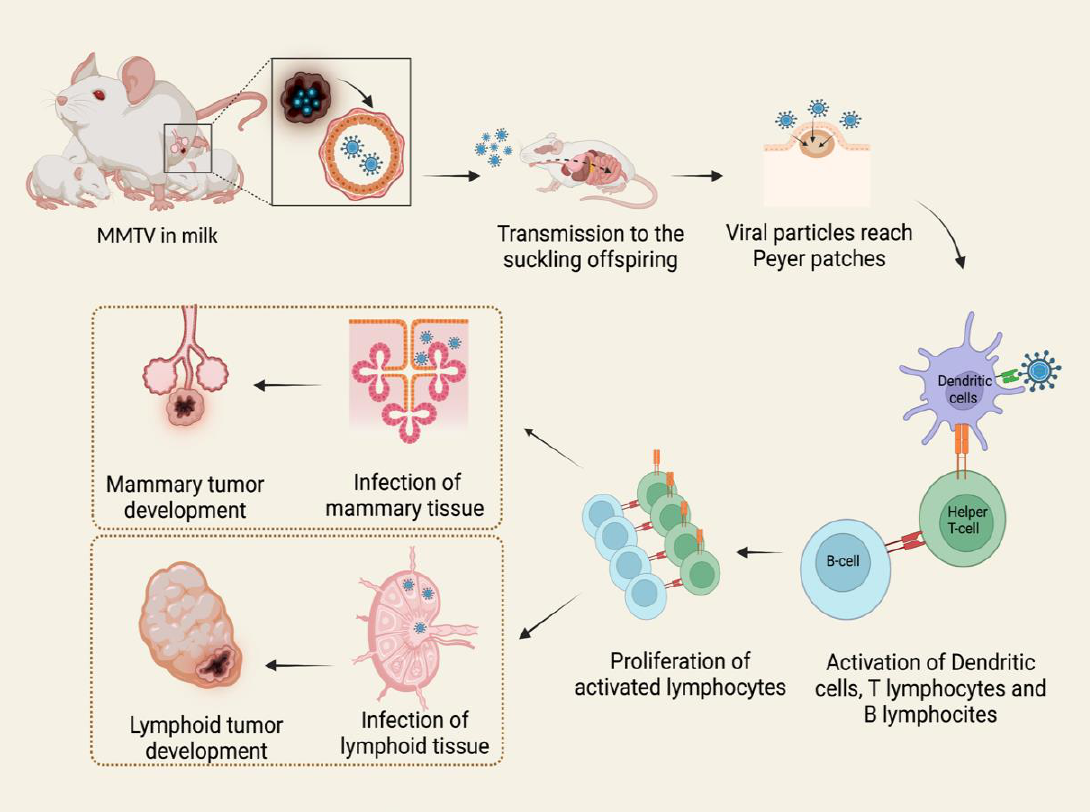
Figure 1. MMTV exogenous cycle. Viral particles transmitted through milk from mother to offspring infect antigen presenting cells in Peyer’s patches of the gut. The subsequent activation of B lym- phocytes and T helper lymphocytes causes the expansion of different immune cell clones and the proliferation of both infection-competent and infected cells. MMTV-infected lymphocytes carry the virus to mammary glands and other tissues, among which are lymphoid tissue, causing neoplasms by different mechanisms. Created by Biorender.com accessed on 14 March